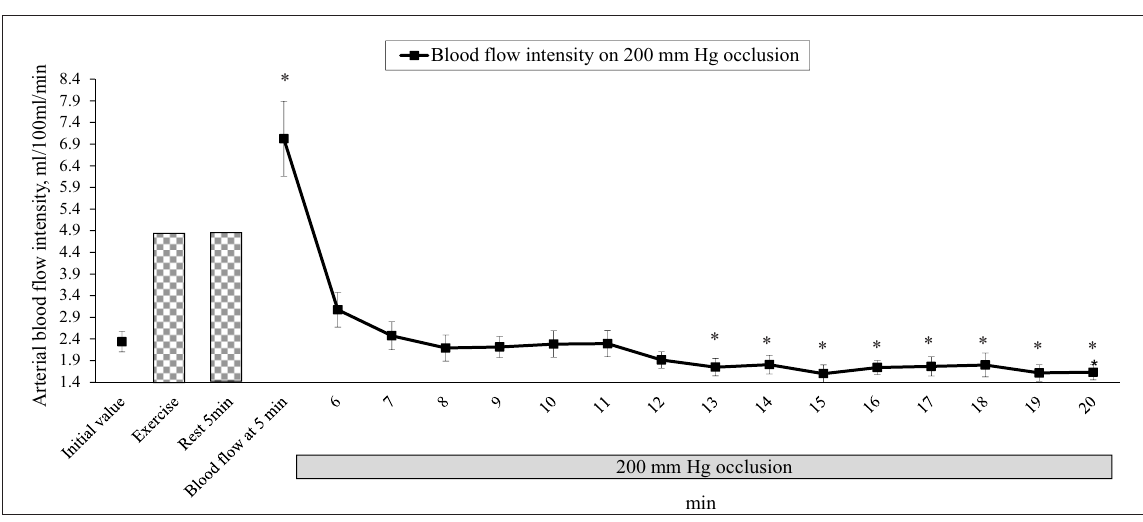
groupNote. * – p < 0.05, compared with the initial Figure 5. Blood flow intensity during 15-minute occlusion in the experimental Figure 5. Blood flow intensity during 15-minute occlusion in the experimental group